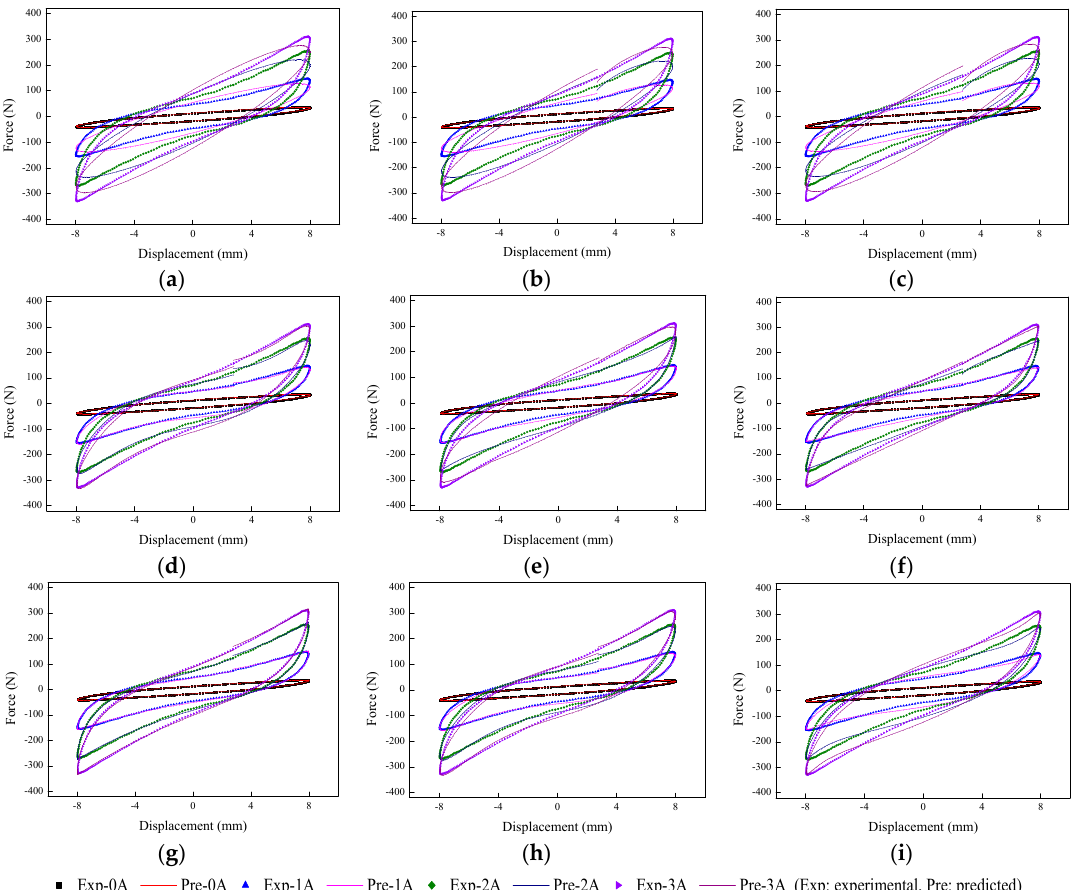
Figure 20. Comparisons of force–displacement responses between experimental results and model predictions when the loading frequency and amplitude are 1 Hz and 8 mm. ( a ) Kelvin–Voigt model, ( b ) four-parameter viscoelastic model, ( c ) rheological model, ( d ) BW model, ( e ) improved BW model, ( f ) Dahl model, ( g ) improved LuGre friction model, ( h ) strain stiffening model, and ( i ) hyperbolic hysteresis model.